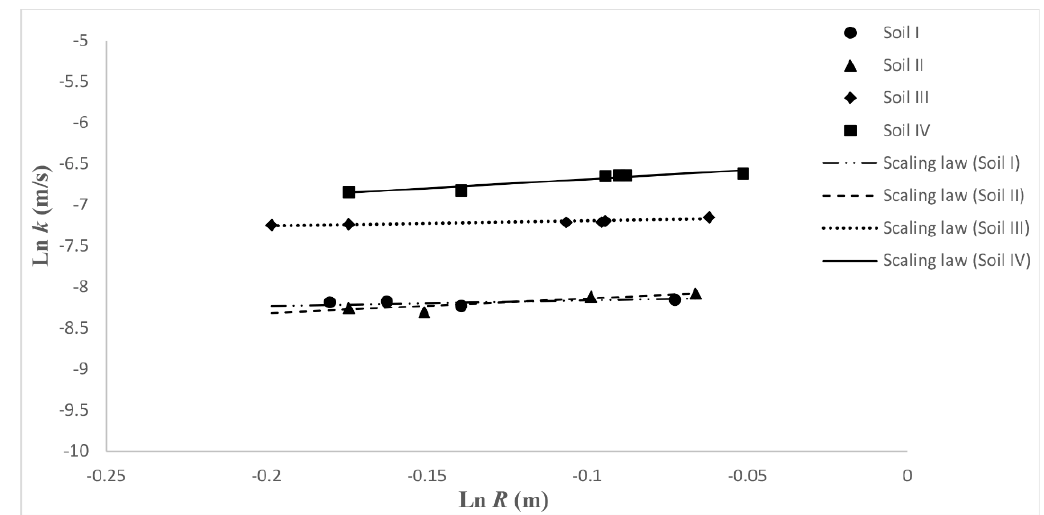
Figure 4. Scaling laws K = K ( R ) for the four soil configurations considered.